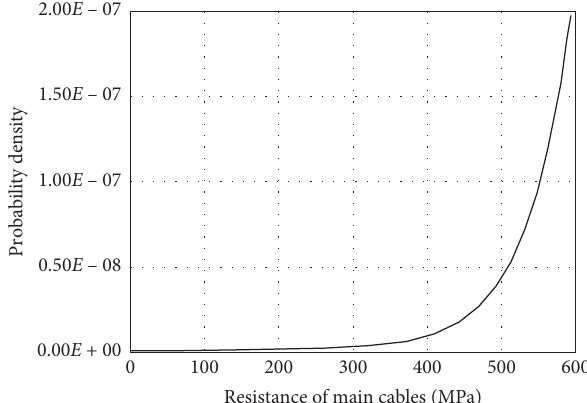
Figure 12: The probability density of resistance of the main cable predicted from the Rice formula.